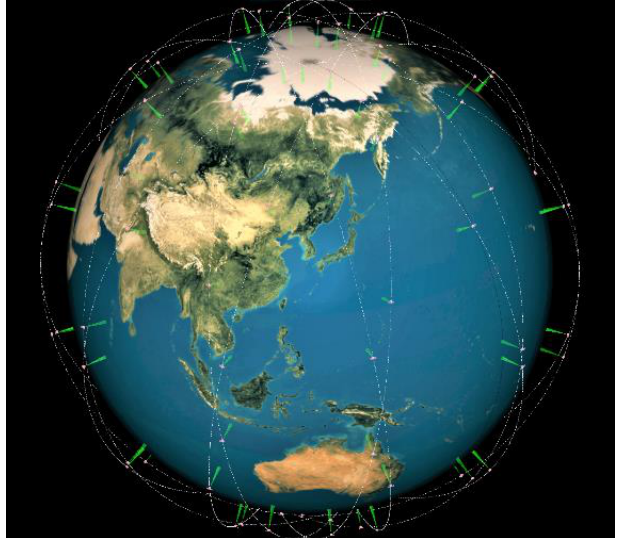
Figure 7. Satellite constellation configuration.